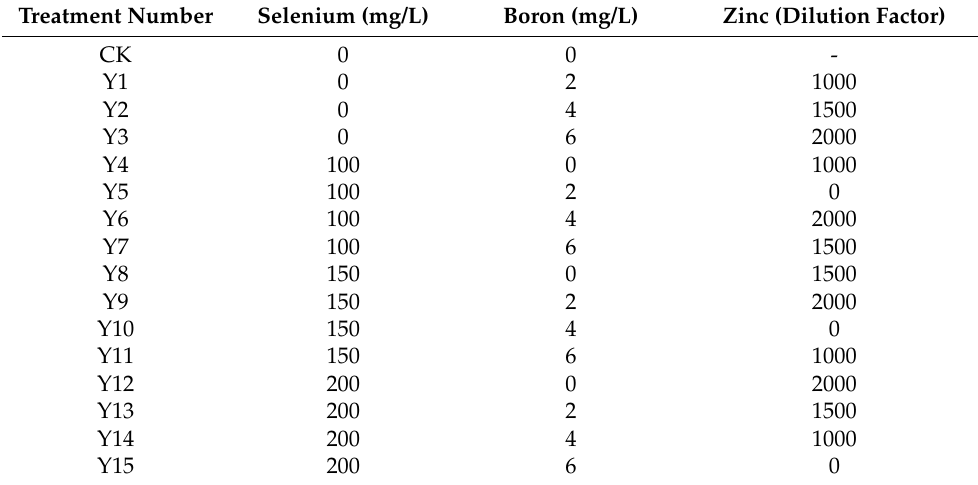
Table 1. Orthogonal design